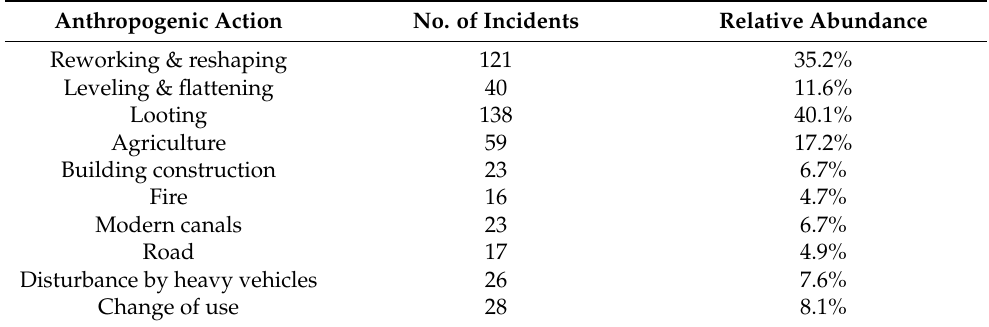
Table 3. Number of incidents for each most impacting anthropogenic action and relative abundance expressed in percentage over the total number of mapped